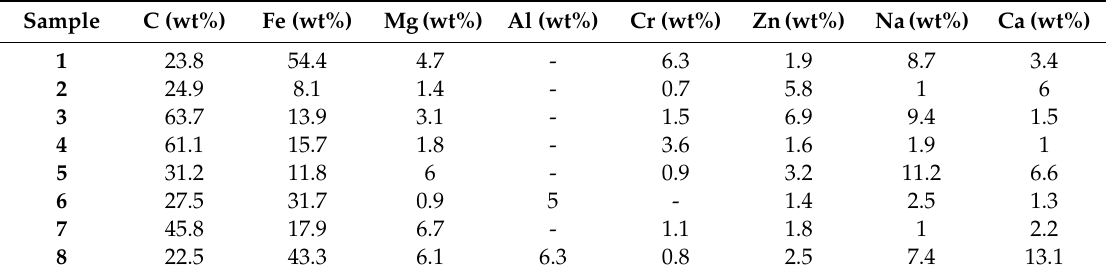
Table 3. Composition of major chemical elements in selected DPM samples, measured by LIBS using calibration curves. Showing average values in